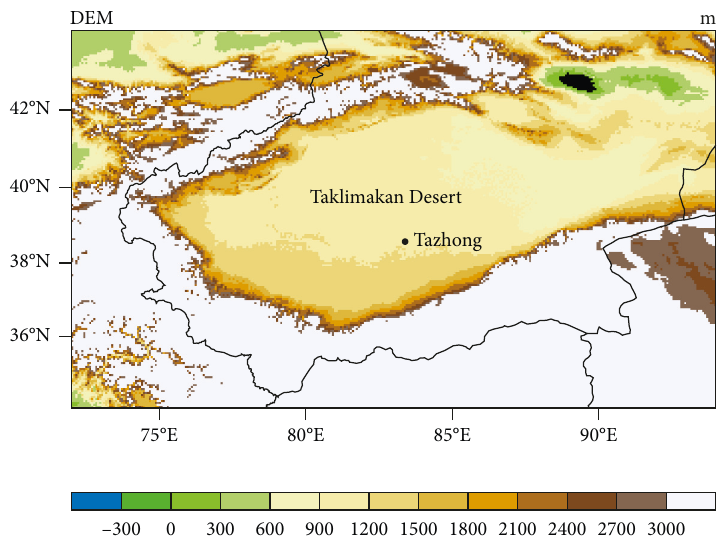
Figure 1: Location of the Tazhong station in the Taklimakan